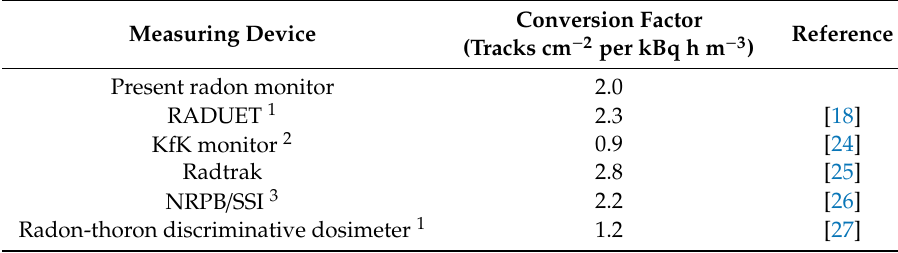
Table 3. Conversion factors of various passive radon monitors.